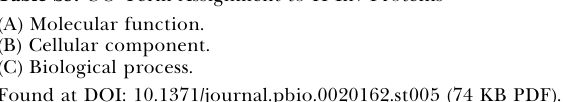
Table S6. List of Newly Assigned Human Enzymes (32 H-Inv Proteins) All these 32 H-Inv proteins were newly assigned enzyme numbers with the support of the KEGG pathway. These enzyme assignments were previously unrepresented in Homo sapiens. Table S7. A Functional Classification of Representative H-Inv cDNAs That Have Homologs in Other Species (See also Figure 6.) Table S8. Basic Statistics for UTR Sequences Analyzed Table S9. UTR Replacements in Primates and Rodents One hundred and forty-seven UTR replacements distributed among different species were detected. Table S10. List of the Databases and Software Used in the H-Inv Project Protocol S1. A Detailed Functional Annotation Based on Protein